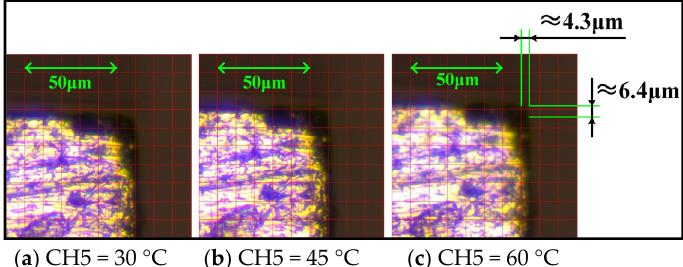
Figure 8. Micro thermal deformation images of the sharp edge as temperatures rose.